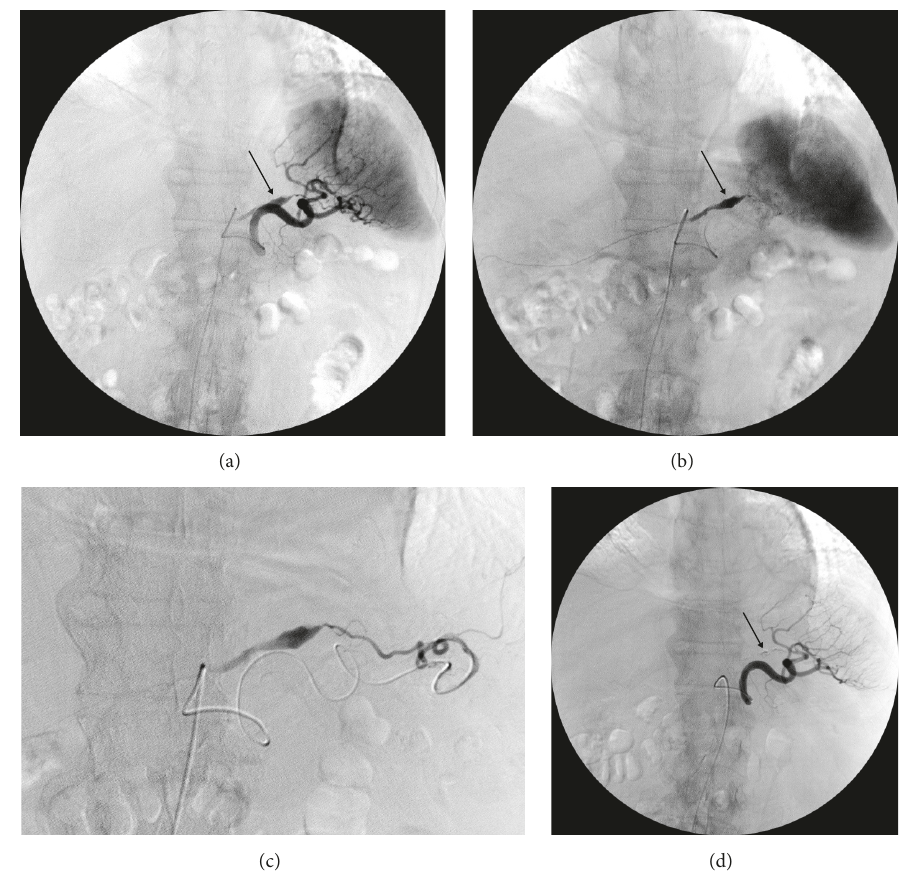
Figure 3: Digital subtraction angiograms. Splenic arteriogram (a) with a markedly dilatated segment, respectively, spindle-shaped aneurysm (arrow) of the left omental artery (LOA), better visible in the late phase (b) and with separate origin of the LOA from an inferior splenic pole artery. Superselective arteriogram of the LOA (c) before embolization (noteworthy, the tortuous microcatheter in the substantially elongated splenicartery).PostembolizationarteriogramofthesplenicarterydemonstratingNBCA-castingandstasisoftheLOA(arrow)withpreserved splenic arteries